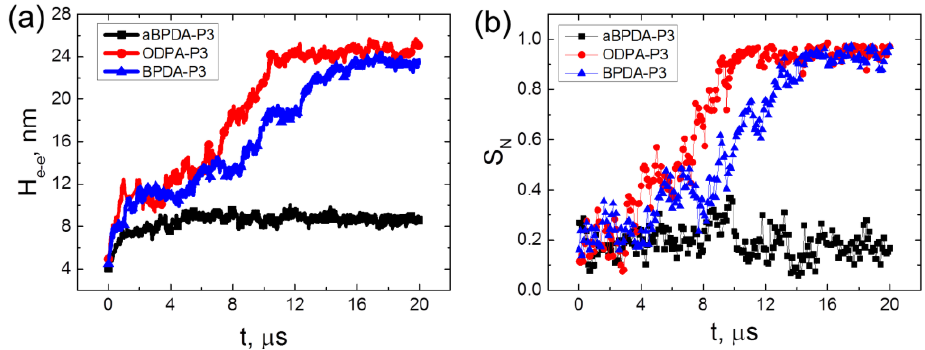
Figure 5. The time dependence of ( a ) the end-to-end distance (H e-e ) and ( b ) the nematic order parameter